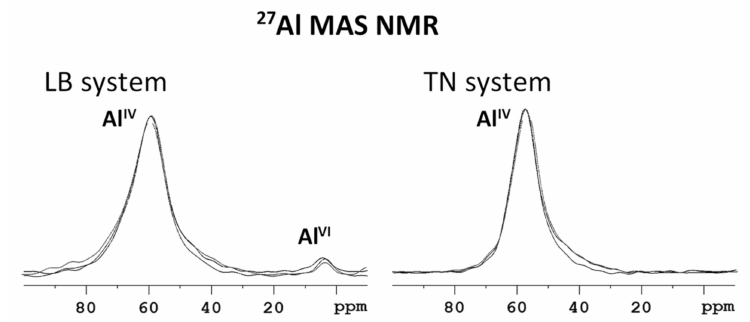
Figure 3. Comparison of 27 Al MAS NMR spectra of neat LB and TN WBD systems, before and after Cs + / Pb 2 + adsorption.